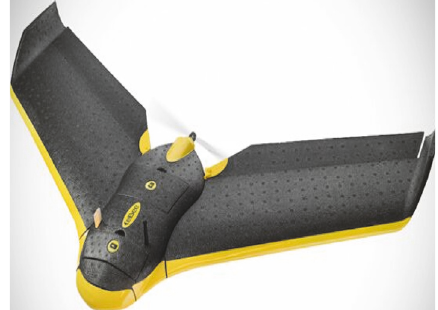
Figure 8: UAV carrier.